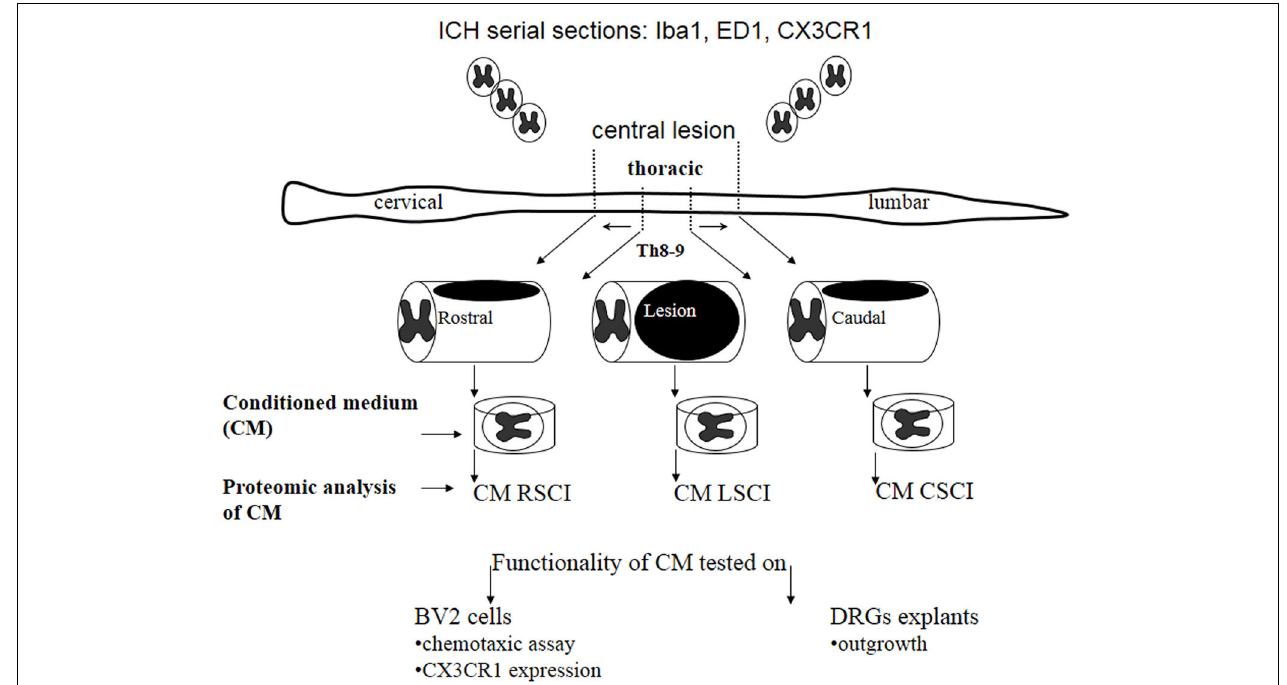
FIGURE 1 | Schematic design of the experimental procedure used in this study.